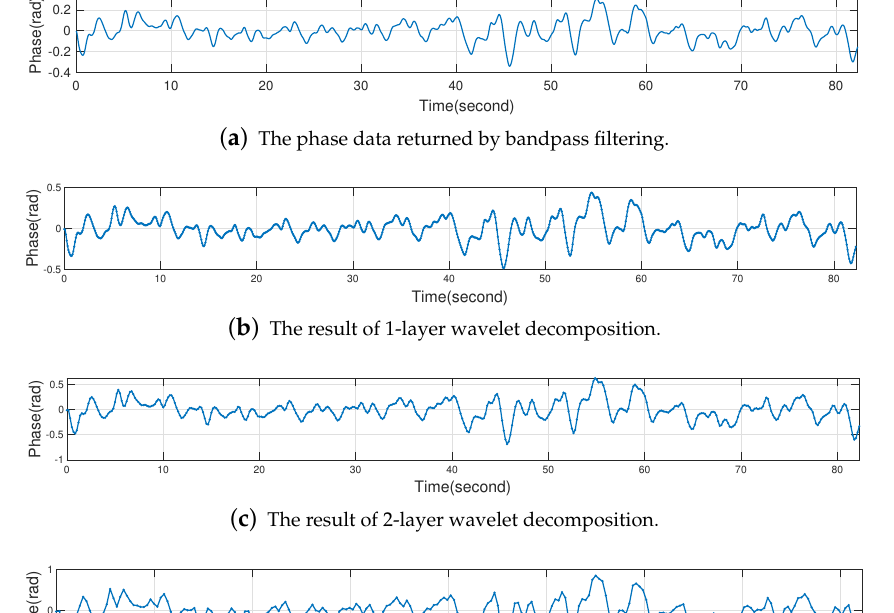
( d ) The result of 3-layer wavelet decomposition.